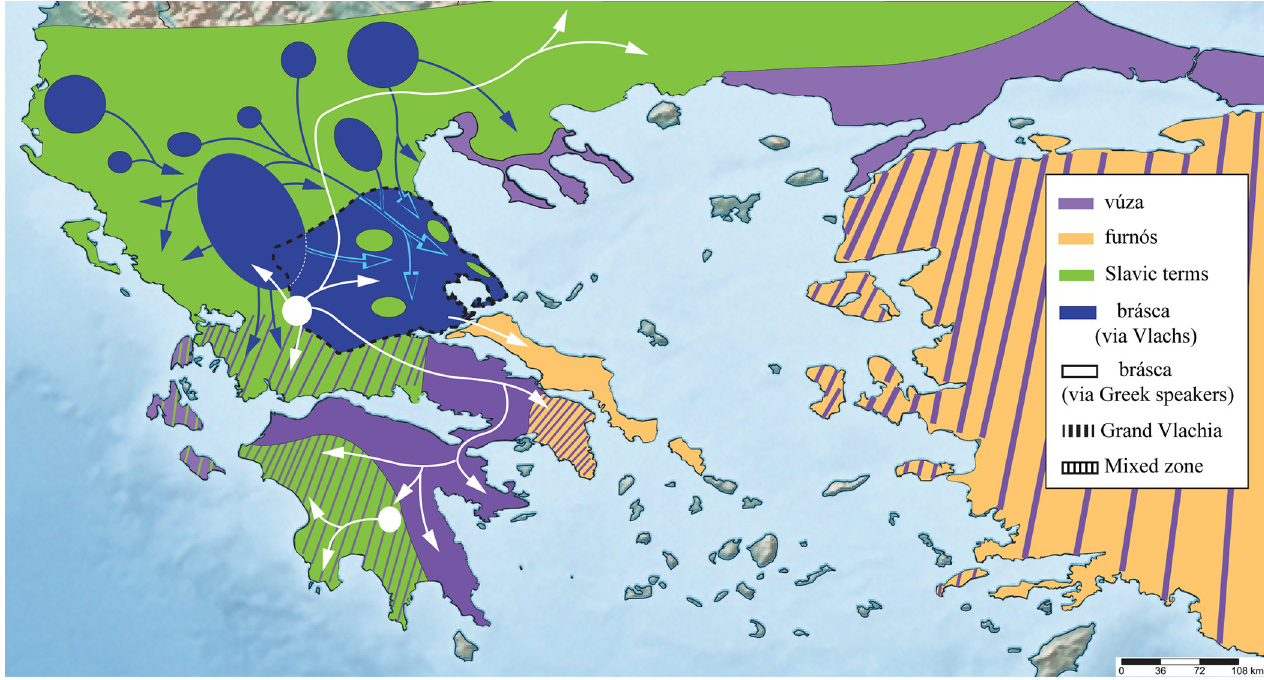
Fig 9. Hypothetical transmission of toad zoonyms postdating the Vlach settlements (9th century onwards). The arrows show the transmission of the term μπράσ κα ( brásca ) by Vlachs (blue) and by Greek speakers (white) respectively, in an indeterminate time frame. The bold dash lines indicate the approximate borders of Grand Vlachia, according to [88, 89]. The distribution of all zoonyms is based on their current range, while the blue circles that act as sources of the term μπράσ κα represent the recorded permanent settlements of the Vlachs and the annual transhumance routes that they followed [42, 79, 90, 91].